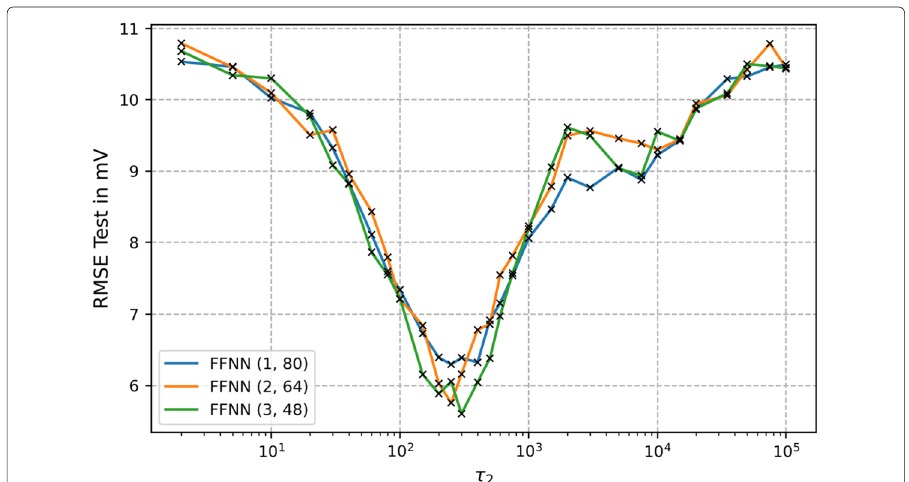
Fig. 9 The performance changes, if the slow history time constant τ CH ,2 is varied. The test set is used to determine the RMSE for three different FFNN architectures, which are notated as (layer,